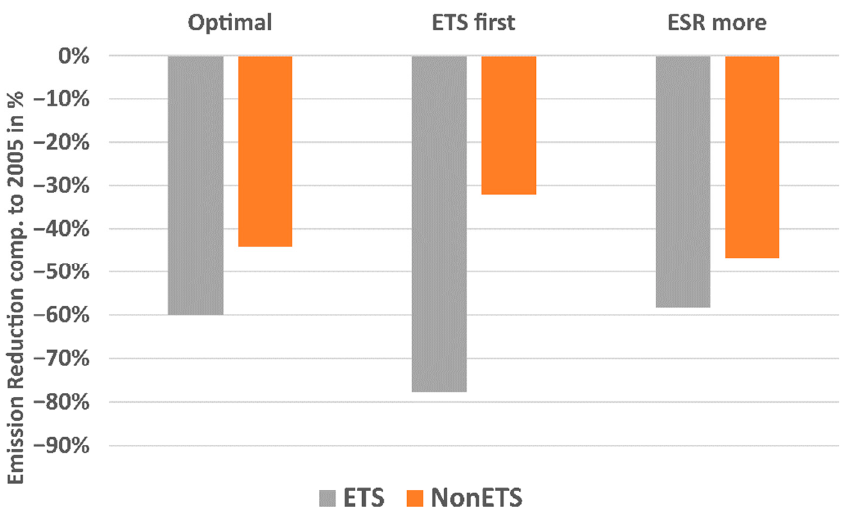
Figure 4. Greenhous gas emissions reduction in 2030.